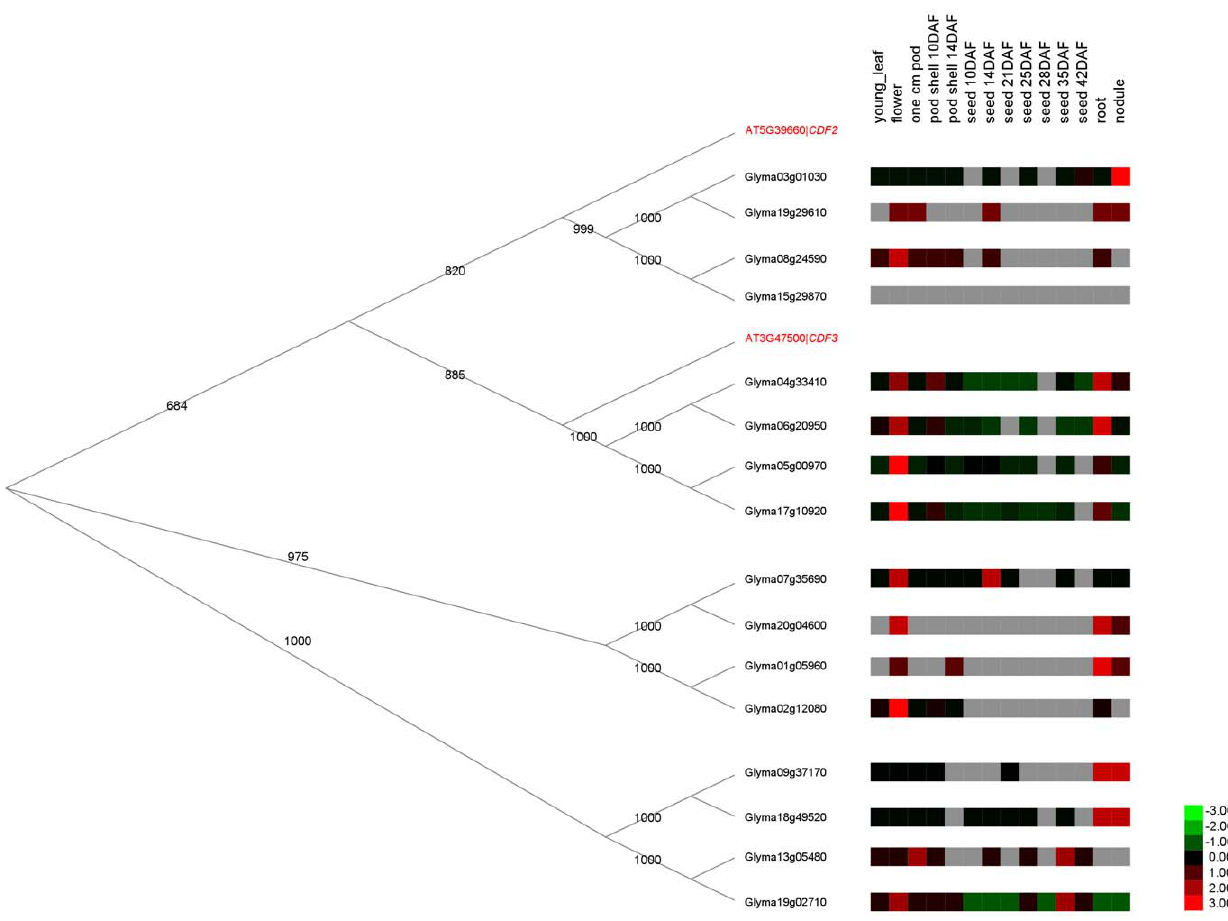
Figure 8. Expression patterns of soybean genes in OG5_150317. While the expression patterns of the 16 soybean genes in OG5_150317 were spread in different clusters as shown in Figure 6, but those that are in the same clade of the phylogenetic tree tend to have similar expression profiles. The expression data were extracted from the soybean transcriptome data in SoyBase [8]. DAF: Days After Flowering.